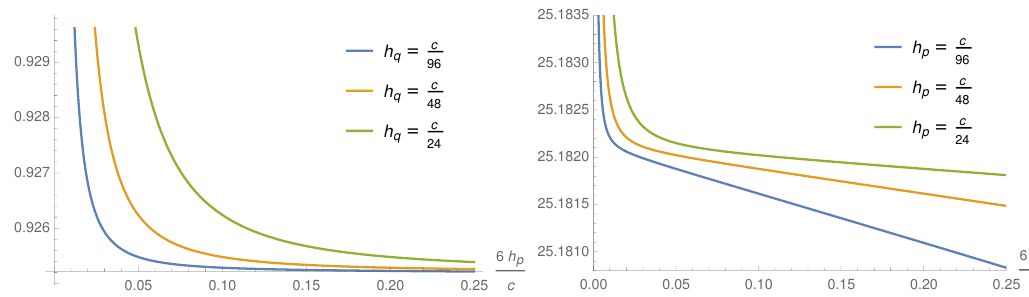
Figure 4 . Derivative of the semiclassical conformal block f cl. w.r.t. h p (left) and h q (right) for z 2 = 0 . 1 , β = 4 π and different values of h p and h q in the range [0 , c/ 24] . Note that the plotted value is greater than zero in all cases, showing that the semiclassical conformal block increases with h p and h q . The series expansion used in this figure was truncated at order 10 in both y and Q .